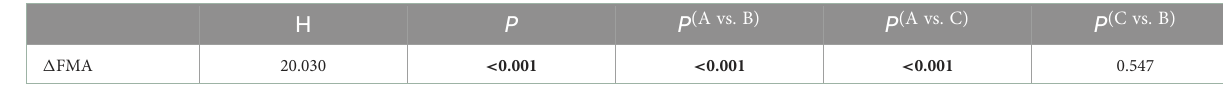
TABLE 2 Comparison of FMA-UE scores before and after treatment among the three groups. Group T0 (FMA) ∗ T1 (FMA) ∗ 1 FMA ∗ P Group A 14 (16) 15 (18) 2 (2) < 0.001 c Group B 9 (12) 15 (10) 4 (2) < 0.001 c Group C 11 (8) 15 (10) 4 (3) < 0.001 c H